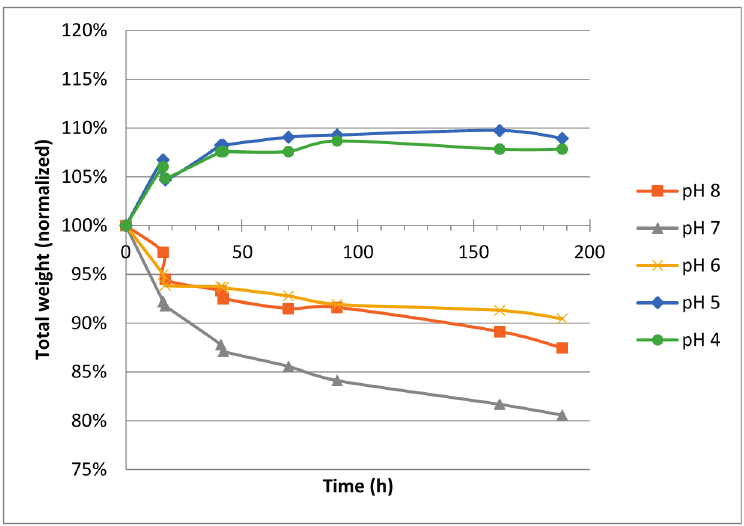
Figure 2. Weight change over time for blocks made from hypotonic ViscoGel™.